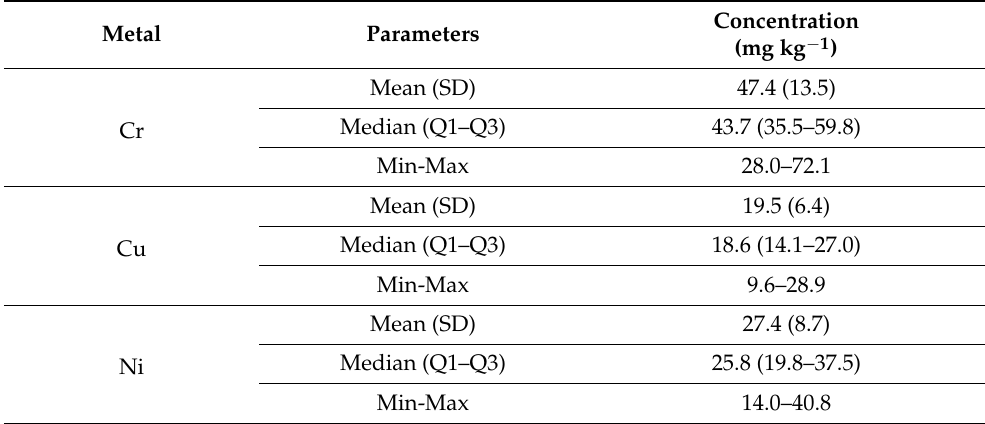
Table 2. Mean concentrations, standard deviations, median (Q1–Q3) and min-max of heavy metals in the soils in mg kg − 1 ; n =